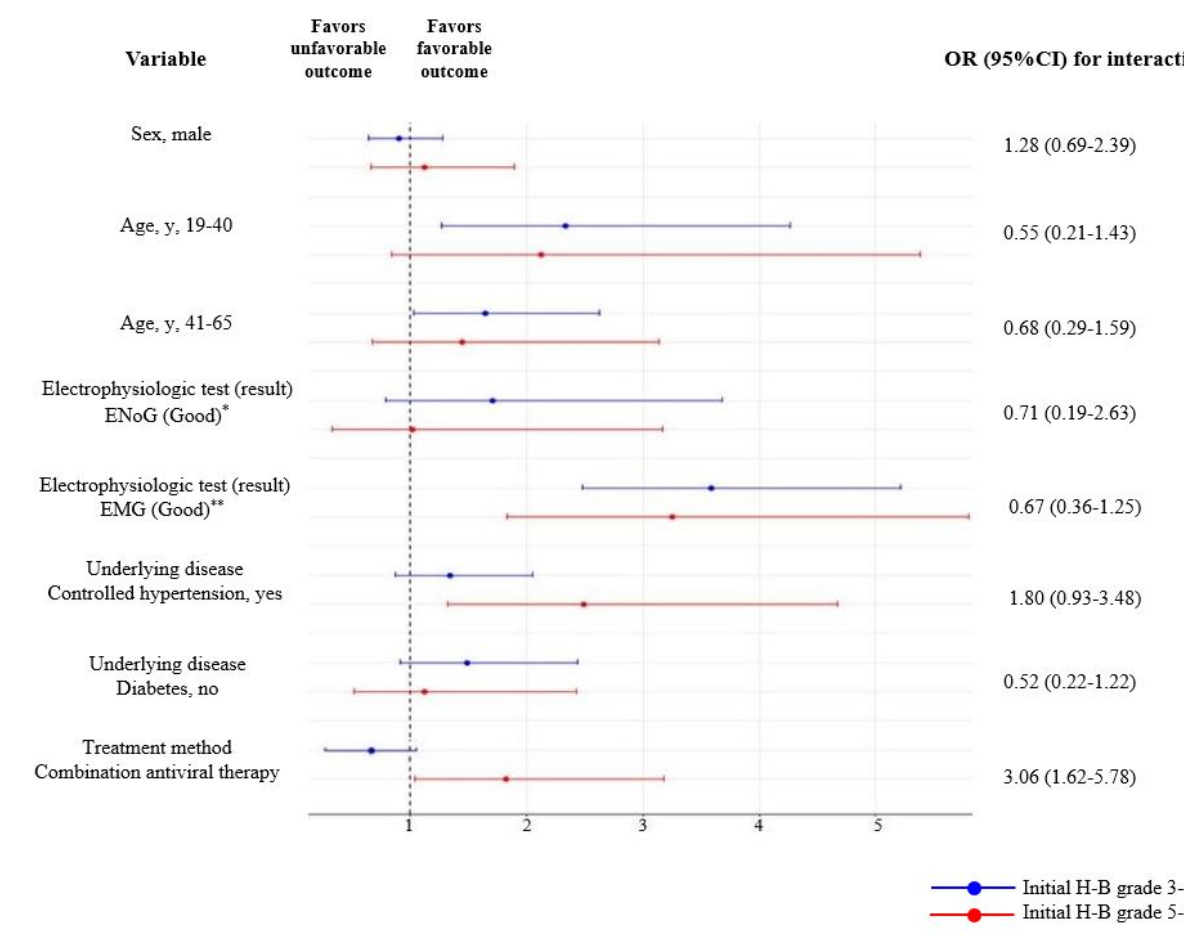
Figure 3. Results of subgroup analysis of secondary outcomes according to the initial H-B grade. The blue lines represent groups with initial House–Brackmann (H-B) grades 3–4, and the red lines represent groups with initial H-B grades 5–6. * Good results were defined as <90% degeneration on the affected side of the facial nerve, ** Good results were defined as the absence of pathologic spontaneous fibrillation activity. 95% CI = 95% confidence interval, H-B grade = House–Brackmann grade, ENoG = electroneuronography, EMG = electromyography.